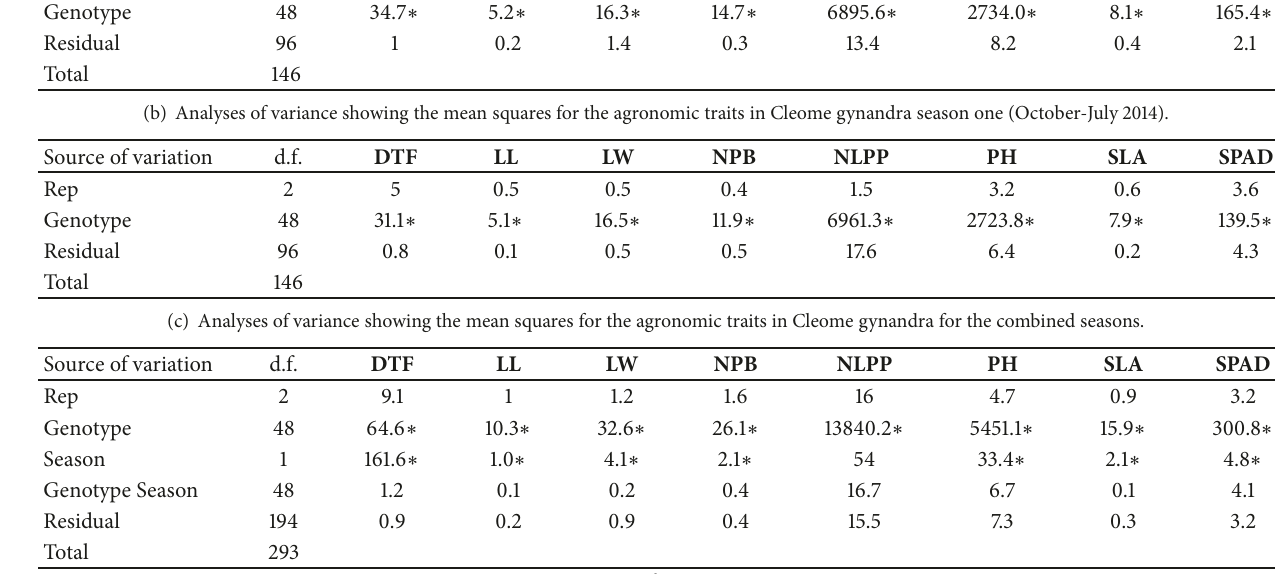
(a) Analyses of variance showing the mean squares for the agronomic traits in Cleome gynandra season one (April-July 2014). Source of variation